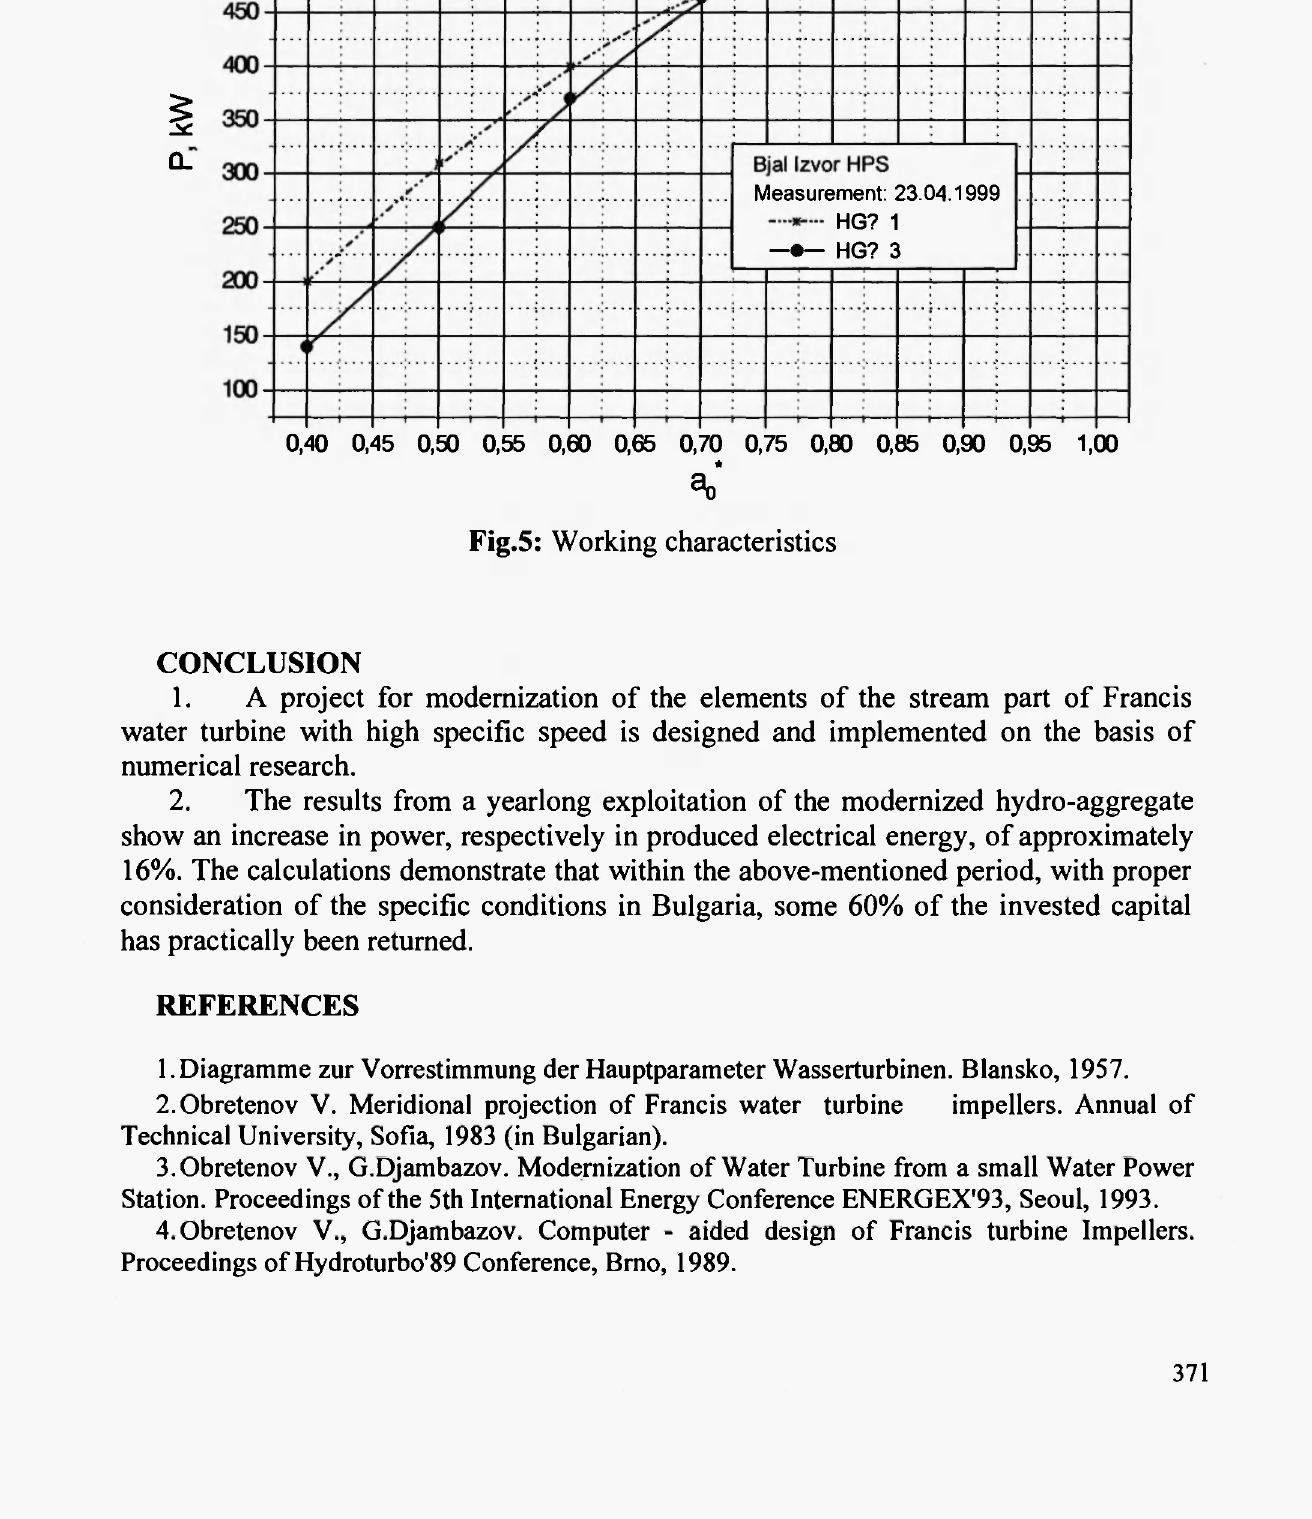
Measurement: 23.04.1999 HG? 1 —·— HG?